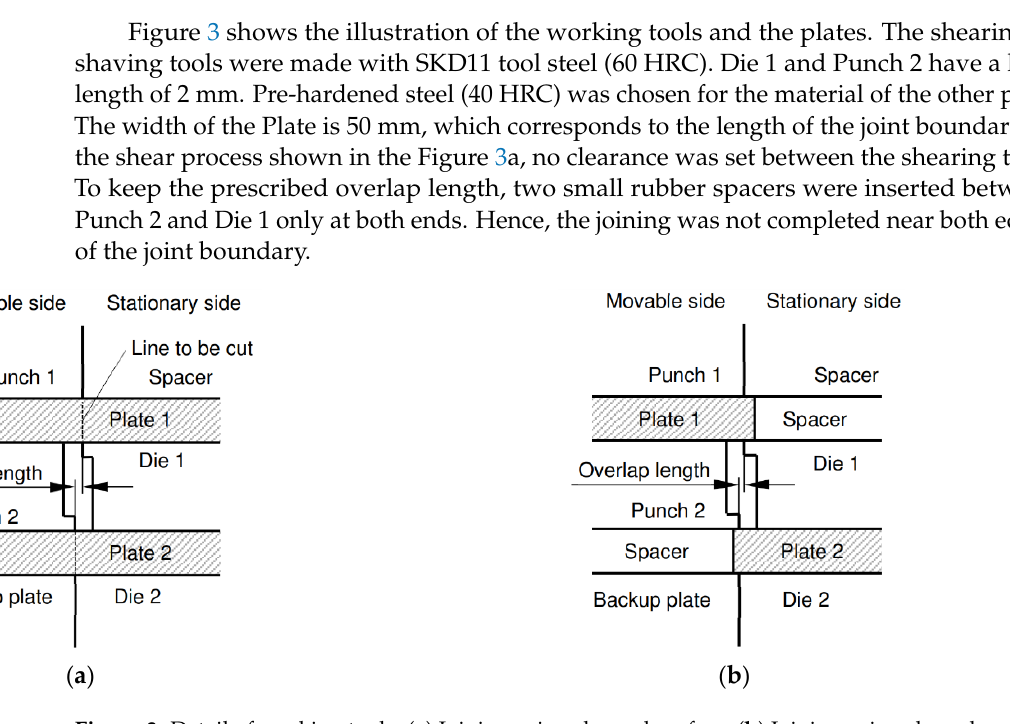
Figure 3. Detail of working tools: ( a ) Joining using sheared surface; ( b ) Joining using shaved surface. Further, the joining test of dissimilar materials was examined for the shaved surfaces.